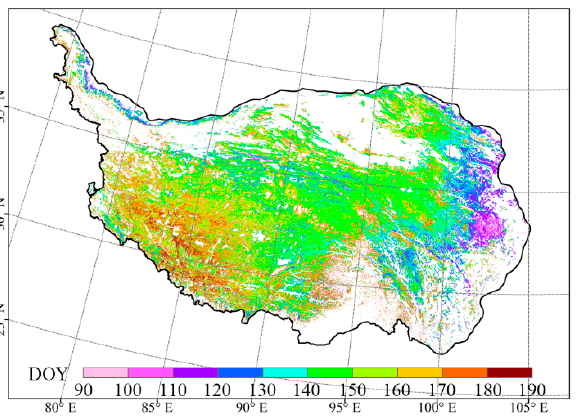
Figure 3. Multi-year mean value of MODIS land surface green-up onset for pixels with detections for at least 10 years from 2000 to 2015.